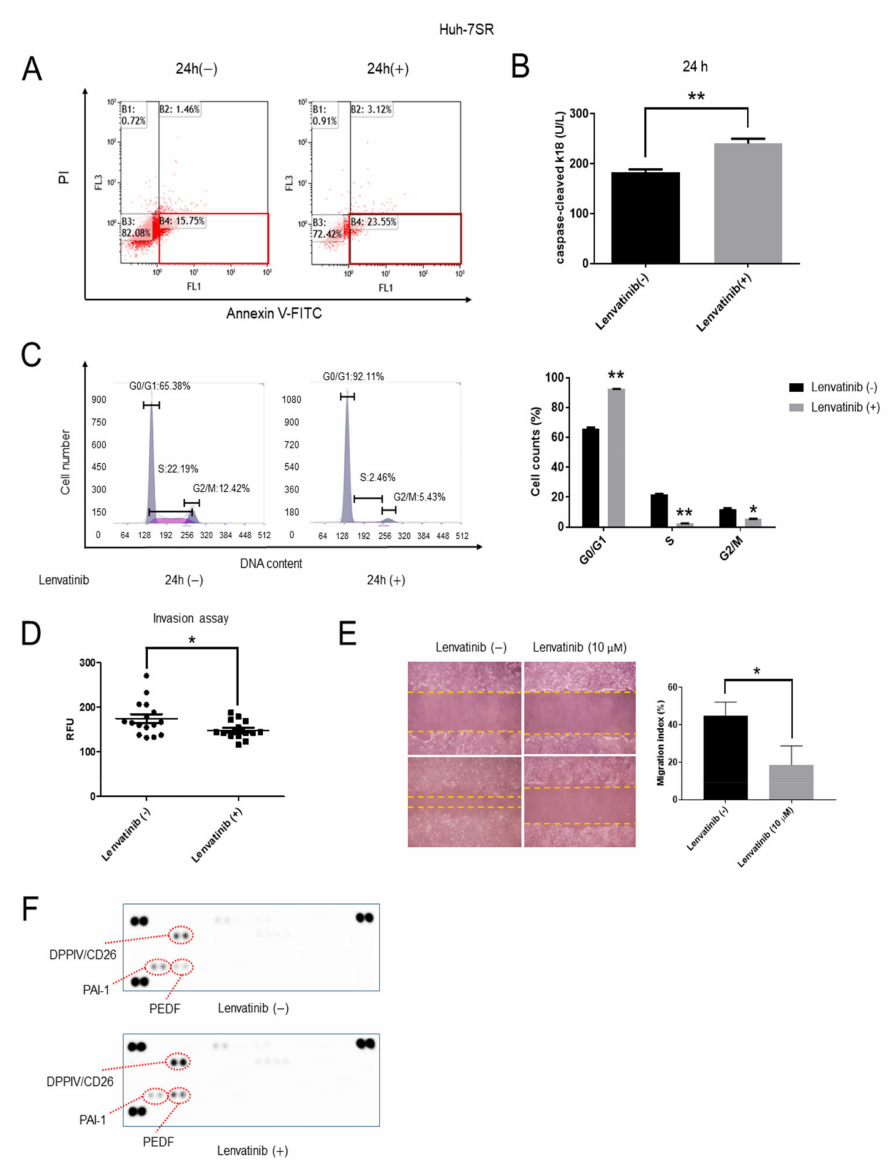
Figure 2. In Huh-7SR cells, lenvatinib induces apoptosis and cell cycle G1 phase arrest, reduces invasion and migration, and modulates the expression of proteins associated with angiogenesis. ( A ) Huh-7SR cells were treated with 10 µ M lenvatinib or dimethyl sulfoxide (DMSO) for 24 h, and the level of apoptosis was measured by staining with annexin V and propidium iodide (PI) using flow cytometry. Lenvatinib treatment increased the proportion of early apoptotic cells in the Huh-7SR population. Lower right square represents early apoptosis. ( B ) The expression of caspase-cleaved cytokeratin 18 (cCK-18) was determined using Enzyme Linked Immunosorbent Assay (ELISA) after 24 h of treatment with 10 µ M lenvatinib. ( C ) Huh-7SR cells treated with 10 µ M lenvatinib or DMSO were analyzed using flow cytometry to determine the number of cells in each phase of the cell cycle (left panel). Representative cell cycle histograms are presented (right panel). Lenvatinib blocked the cell cycle at the G1 phase. ( D ) Invasion ability of lenvatinib-treated Huh-7SR cells was decreased. ( E ) Wound-healing assay comparing the motility of Huh-7SR cells treated with lenvatinib or DMSO. The wound-healing area was analyzed using the ImageJ software. ( F ) Representative expression of angiogenesis-related proteins: plasminogen activator inhibitor-1 (PAI-1), dipeptidyl peptidase-4 (DPPIV/CD26), and pigment epithelium-derived factor (PEDF), in Huh-7SR cells incubated with lenvatinib or DMSO for 24 h. Data are presented from three independent experiments. * p < 0.05, ** p <